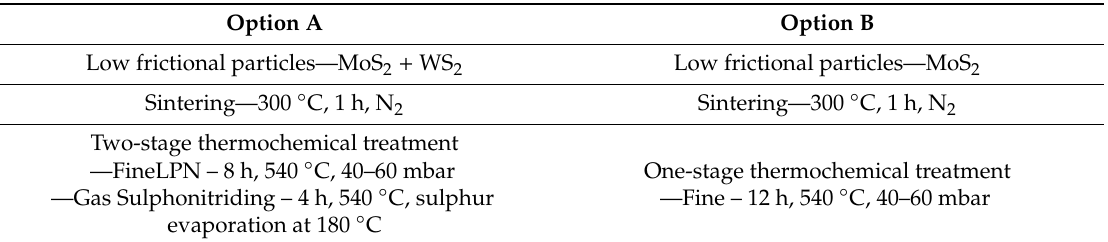
Table 2. Technological Details of Compared Processes